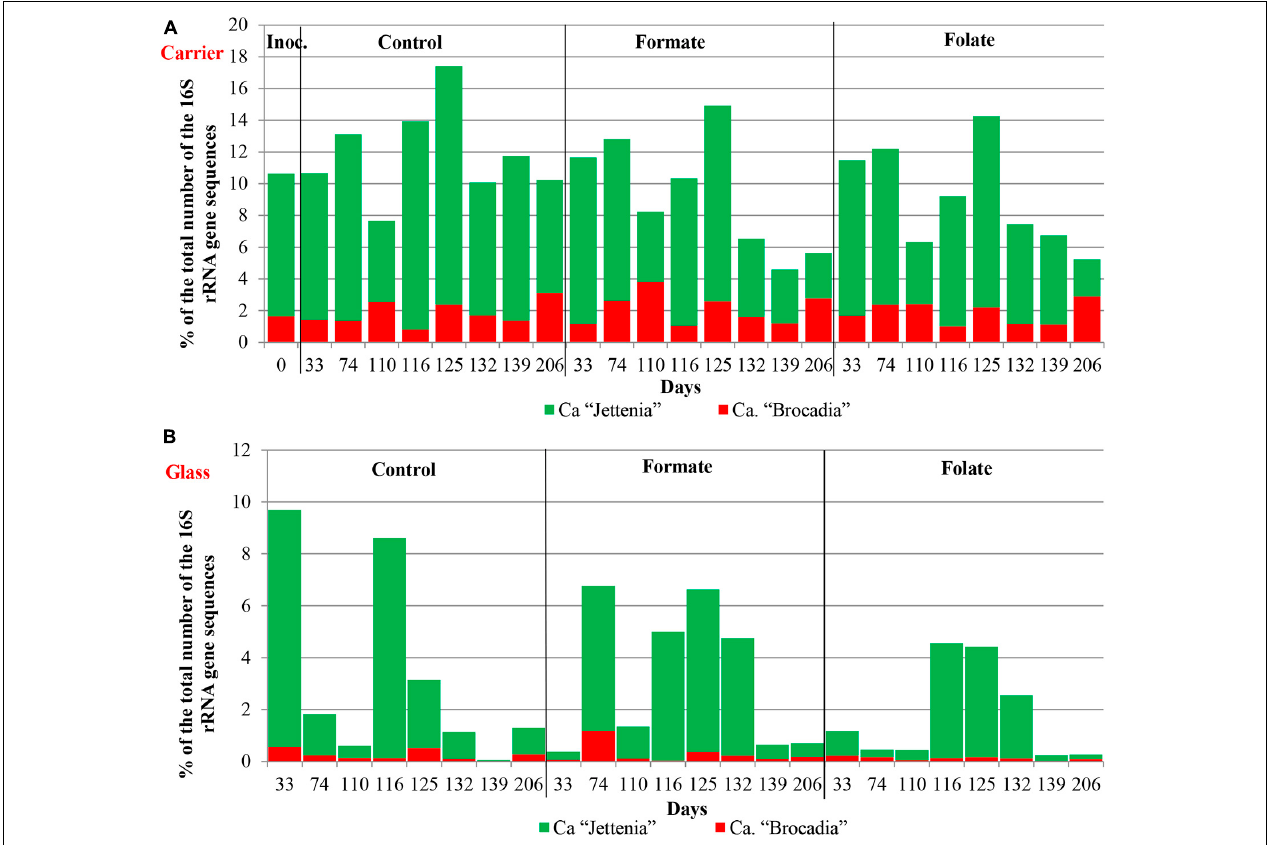
FIGURE 7 | The relative abundance of members of the genera Ca. “Jettenia” and Ca. “Brocadia” in the inoculum and the biomass on the carrier (A) and on the walls of the reactors (glass) (B) before (0–74 days) and after (110–206 days) the additives supplied and the ammonium load increased (the second run of the reactors).